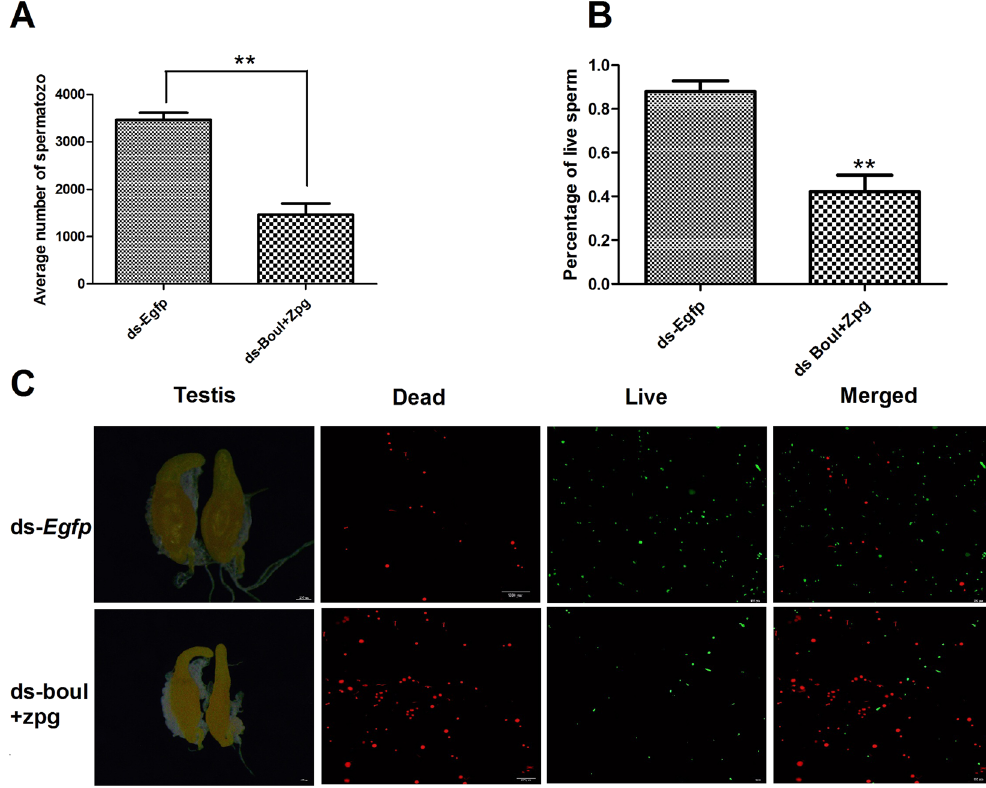
Figure 8. Average number of spermatozoa percentage of dead and live sperms. ( A ) Average number of spermatozoa in seminal vesicles, ( B ) percentage of live sperms per male was determined in seminal vesicles of 20 males per treatment, the effect of treatments was analyzed using T-test. ** indicates P < 0.01. ( C ) Microscopic picture of testis (200 μ m) revealing the dead sperm (100 μ m) (red) and live sperm (100 μ m)